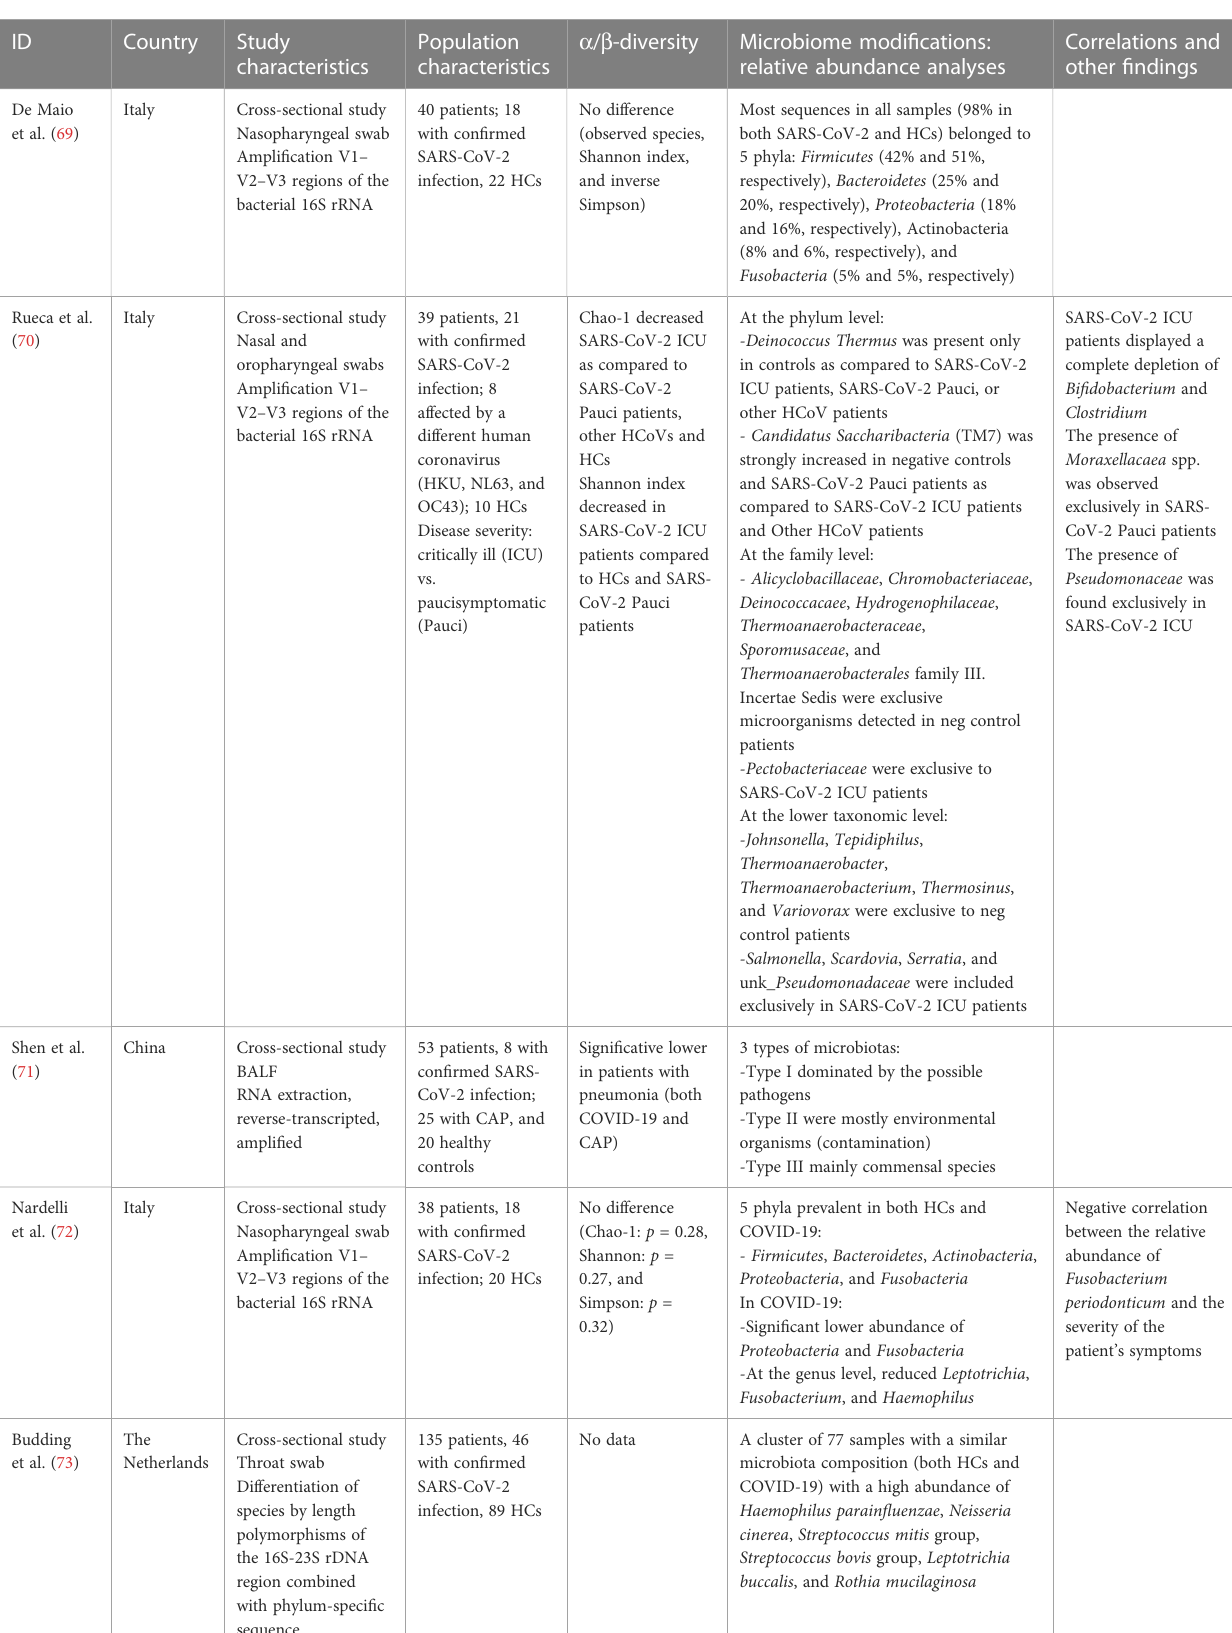
TABLE 1B Selected studies on airway microbiota and